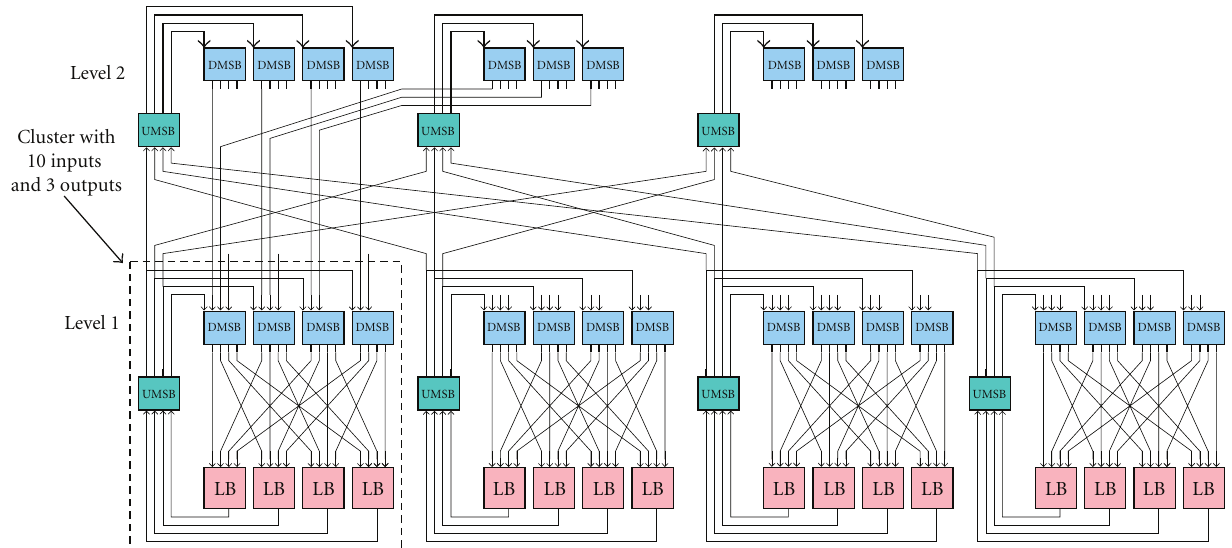
Figure 2: Tree-based interconnect depopulation using Rent’s rule (level 1 with p = 0 .